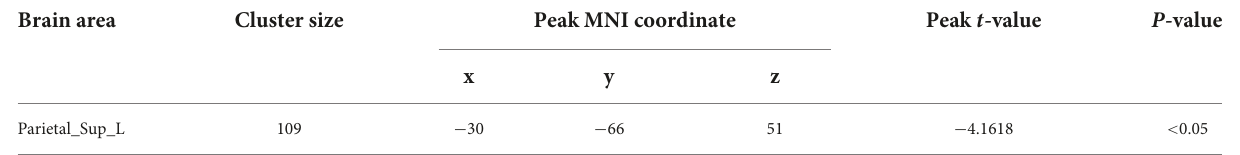
TABLE 2 Brain regions with abnormal FCS in CI group compared with HCs. Brain area Cluster